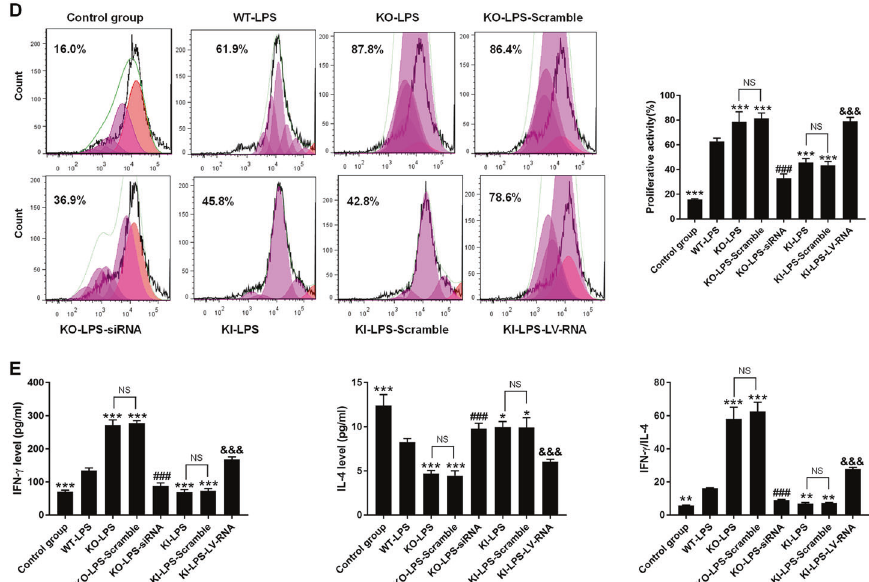
Fig. 3 Negative regulation of the immune function of DCs by TIPE2 in vitro. DCs were isolated from murine splenocytes with different TIPE2 genetic designs. DCs were transduced with lentiviral vectors (Beclin-1 knockdown and Beclin-1 overexpression), and scramble cells were transduced with blank vector. A ① Transduced cells were analyzed by fl uorescence microscopy (×400), scale bar = 200 μ m, and then green fl uorescence protein (GFP)-positive ef fi ciency was evaluated using fl ow cytometry. ② Protein levels of Beclin-1 were determined by western blotting. B Representative fl ow cytometric analysis of CD80, CD86, and MHC-II expressions on DCs in vitro. C Expressions of cytokines (IL- 12p40 and TNF- α ) by DCs were measured by ELISA. D Proliferation of CD4 + T cells was examined by CFSE staining after incubating with DCs in a 100:1 ratio for 72 h. E IL-4 and IFN- γ levels in culture medium were determined by ELISA to evaluate Th1/Th2 polarization. Data obtained from three independent experiments are represented as mean ± SD ( n = 6 in each group). Statistical signi fi cances: A compared with the Normal group or the Scramble group, *** P < 0.001. B – E Compared with the WT-LPS group, * P < 0.05, ** P < 0.01, *** P < 0.001; compared with the KO-LPS group, ### P < 0.001; compared with the KI-LPS group, &&& P < 0.001. NS means no statistical difference between the two groups.